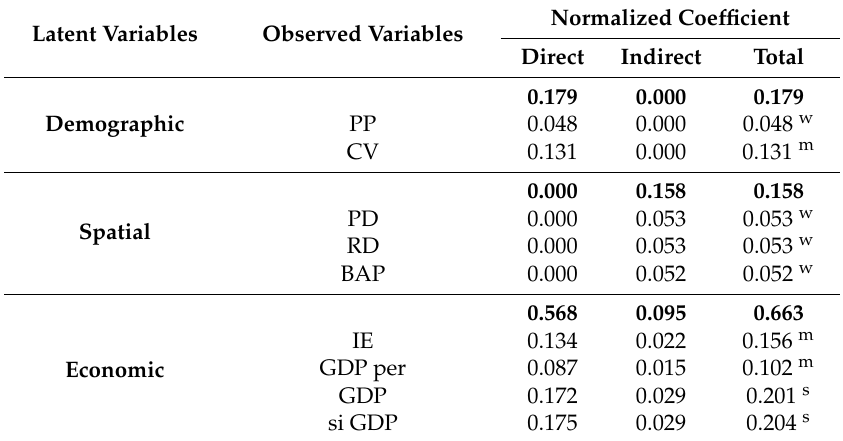
Table 3. The influence of urban socioeconomic variables on PM 2.5 pollution in China. Latent Variables Observed